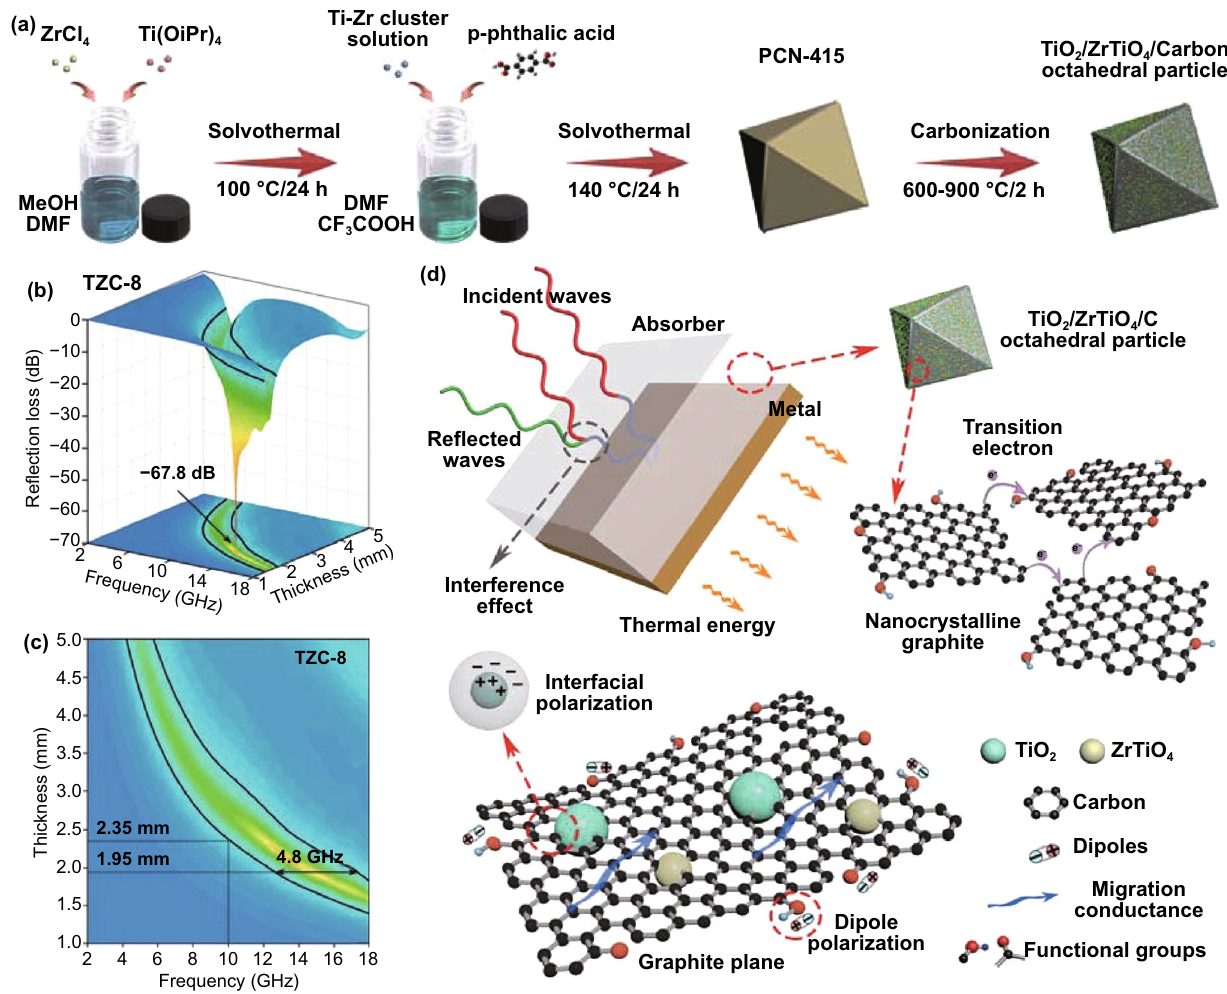
Fig. 10 a Diagrammatic sketch of the preparation. b 3D RL-f curves, c 2D RL projection mapping and d schematic illustration of the MA mechanism of TiO 2 /ZrTiO 4 /carbon nanocomposites. Reprinted with permission from Ref.